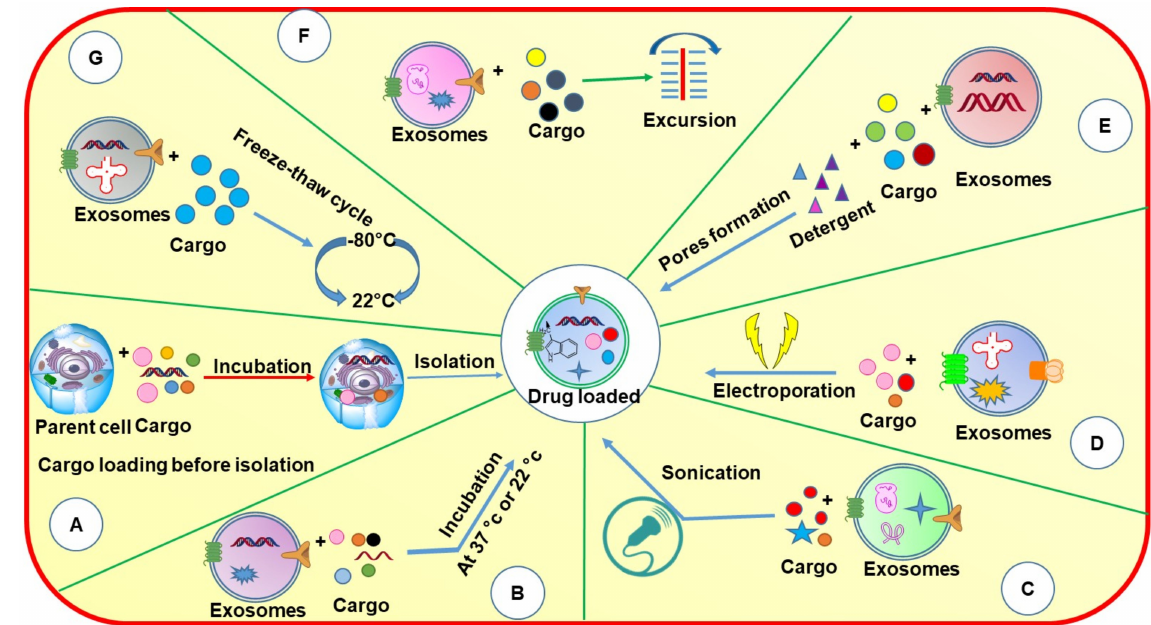
Figure 5. Schematic diagram showing different methods of loading cargos into exosomes through pre-loading and post-loading strategies: ( A ) incubation with parent cell; ( B ) incubation; ( C ) sonication; ( D ) electroporation; ( E ) detergent method; ( F ) excursion; ( G ) freeze–thaw